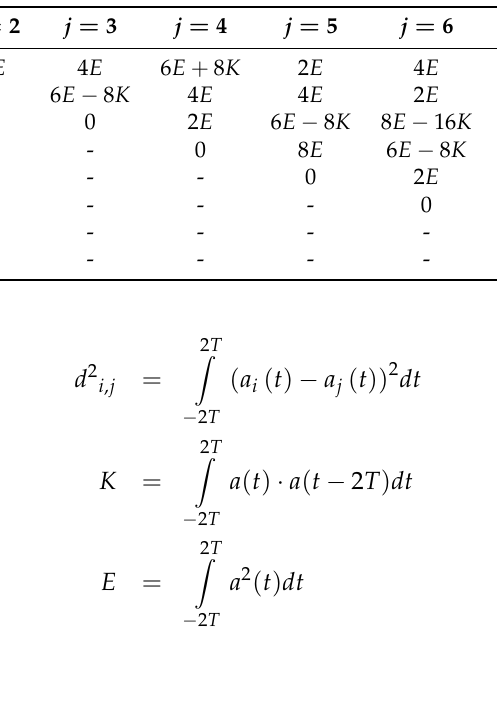
Figure 3. Synthetic waveforms of three bits random baseband symbols in the interval [ − 2 T ,2 T ] . Table 1. Euclidean distance between any two